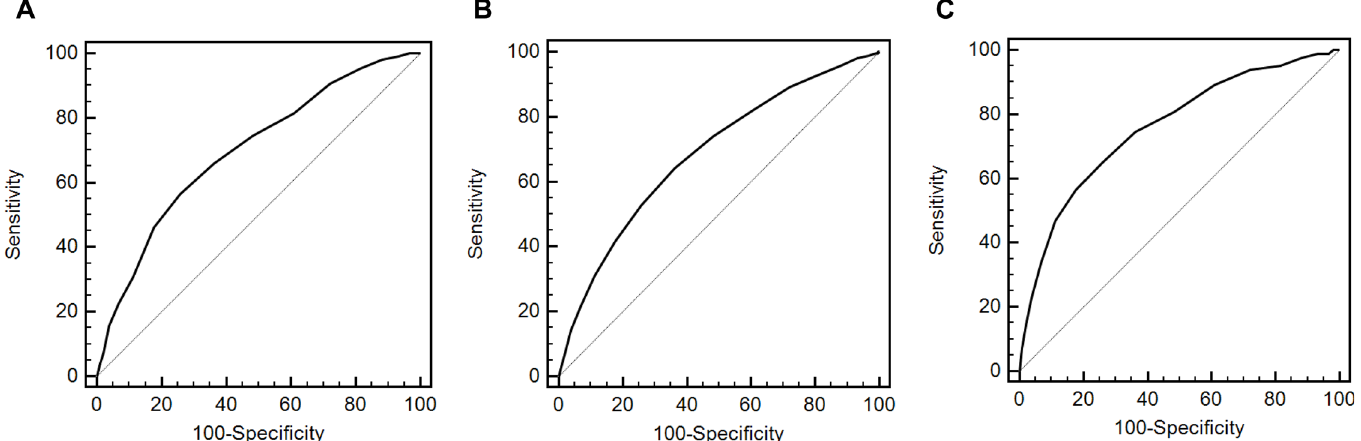
Fig 1. Receiver operating characteristic curves of HbA1c for the prediction of metabolic syndrome or chronic kidney disease. A. Only metabolic syndrome. B. Only chronic kidney disease. C. Both metabolic syndrome and chronic kidney disease.